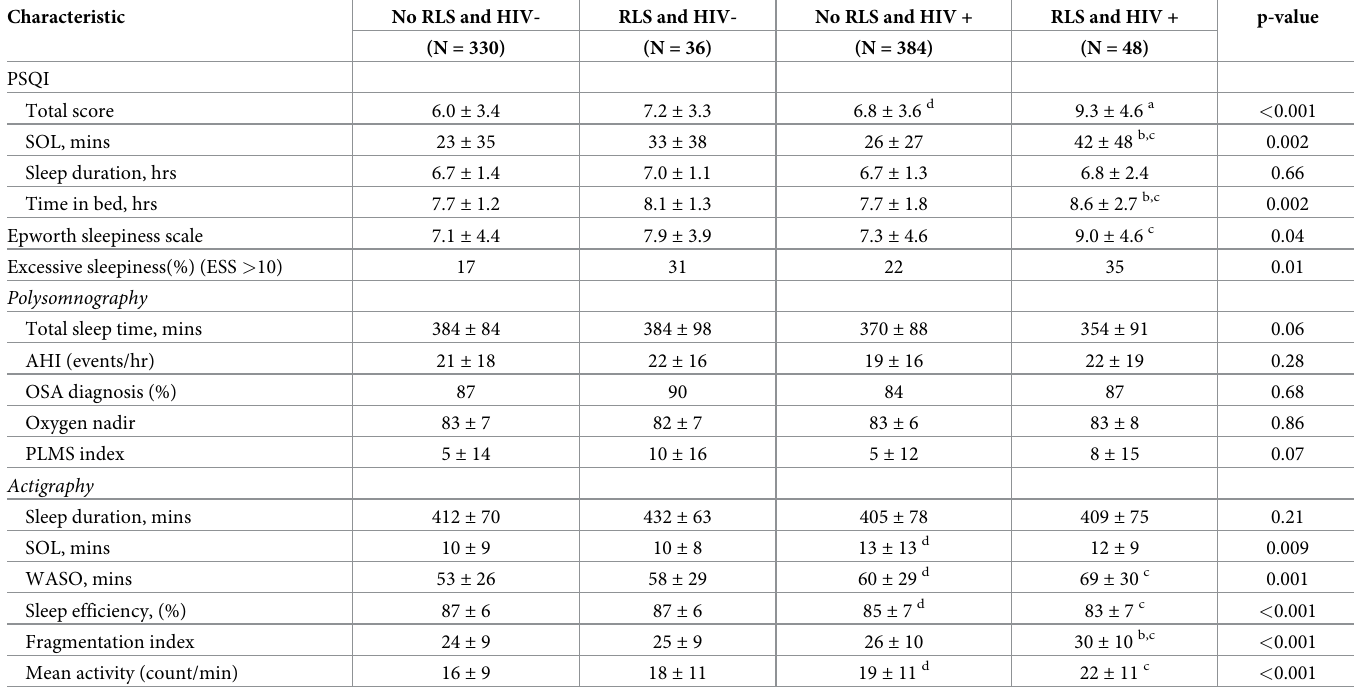
Table 4. Comparison of sleep parameters by HIV and RLS